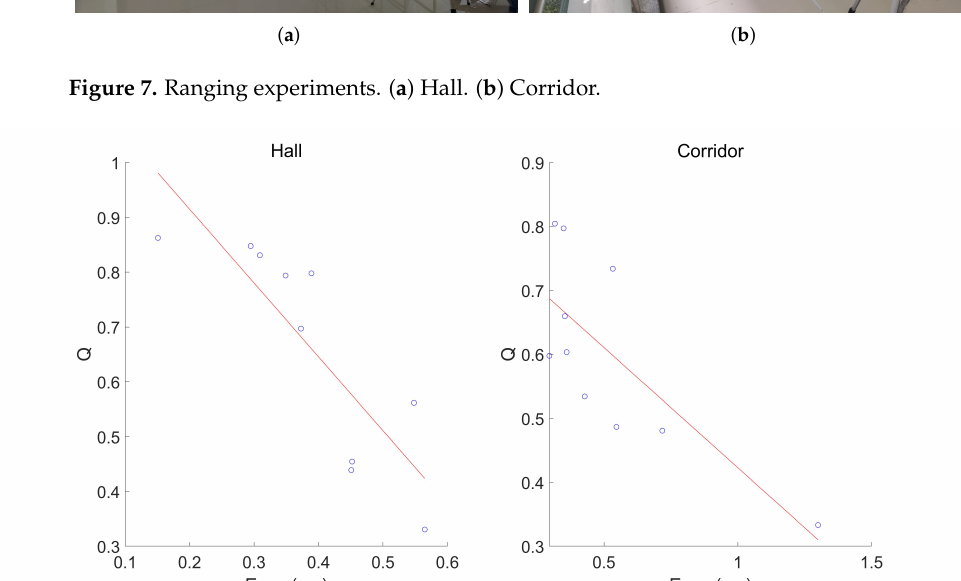
Figure 8. Result of the ranging